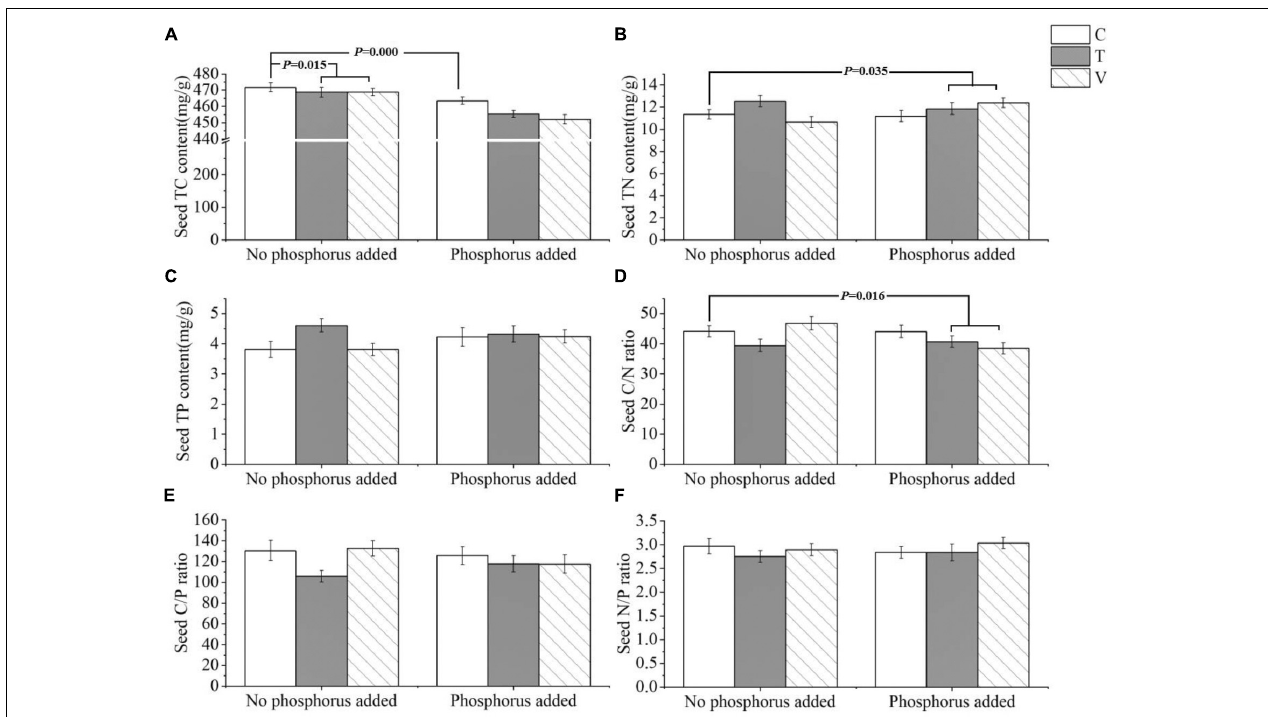
FIGURE 4 | The stoichiometric characteristics of the (A) TC, (B) TN, and (C) TP contents and the (D) C/N, (E) C/P, and (F) N/P ratios of P. crispus seeds under different treatments. The C in “No phosphorus added” represent controls (C), T in “No phosphorus added” represent constant warming (T), and V in “No phosphorus added” represent variable warming (V). Meanwhile, the C in “Phosphorus Added” represent phosphorus addition (C + P), T + P in “Phosphorus Added” represent constant warming and phosphorus addition (T + P), and V + P in “Phosphorus Added” represent variable warming and phosphorus addition (V + P).